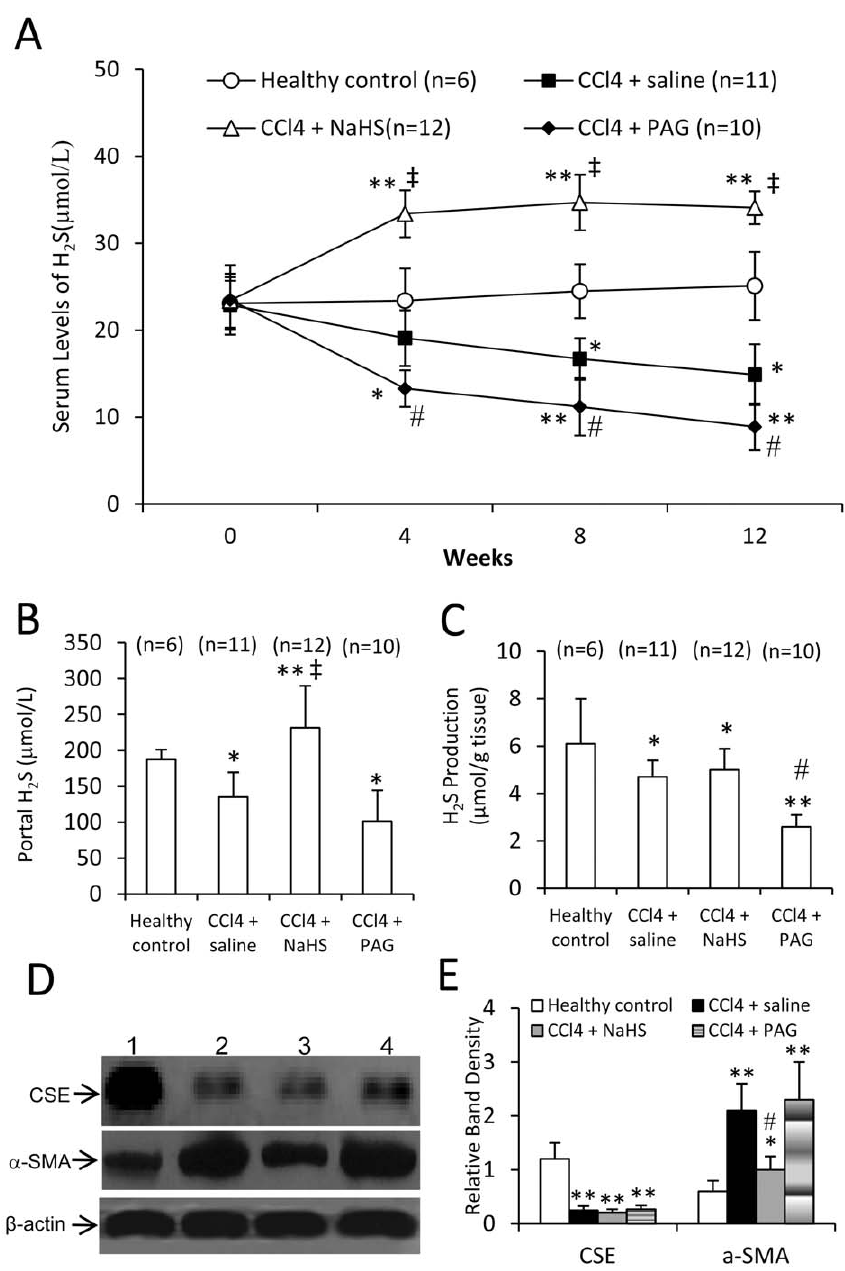
Figure 2. Serum H 2 S levels, H 2 S production, and expression of CSE and a -SMA in the prevention experiment. The rats were treated with CCl 4 + saline, CCl 4 + NaHS or CCl 4 + PAG for 12 weeks. Untreated rats served as healthy controls. (A) Blood samples were collected at indicated time points, and the serum levels of H 2 S were measured. The statistical comparison between two groups was done at the respective time point. (B-E) The rats were killed at the completion of experiment. Blood samples were collected from portal vein, and livers harvested. The levels of H 2 S in sera from the portal vein (B), and H 2 S producing activity in livers (C) were measured. (D) The expression of CSE and a -SMA was detected in livers from healthy controls (lane 1), or rats treated saline + CCl 4 (lane 2), NaHS + CCl 4 (lane 3) or PAG + CCl 4 (lane 4) by Western blot analysis. (E) The density of each band was measured and compared to that of the internal control, b -actin. Results are expressed as mean 6 SD. n, number of samples. Compared to the healthy controls, a significant difference is denoted by ‘‘*’’, a highly significant difference by ‘‘**’’ (P , 0.001). Compared to saline + CCl 4 -treated rats, a significant increase is denoted by ‘‘ { ’’, and a significant reduction is denoted by ‘‘ # ’’. doi:10.1371/journal.pone.0025943.g002 CCl 4 -induced cirrhotic rats, than saline, at all the three time points PAG did not significantly (P . 0.05) decrease, the portal serum (Fig. 2A). The portal serum levels of H 2 S at the completion of levels of H 2 S, in CCl 4 -induced cirrhotic rats, compared with saline experiment was significantly (P , 0.05) lower in CCl 4 -induced (Fig. 2B). We further examined the H 2 S producing activity (Fig. 2 cirrhotic rats receiving injection of saline than the healthy controls C) in livers from CCl 4 -induced cirrhotic rat receiving injections of (Fig. 2B). However, NaHS significantly (P , 0.05) elevated, but saline, NaHS or PAG, and the similar results were obtained as